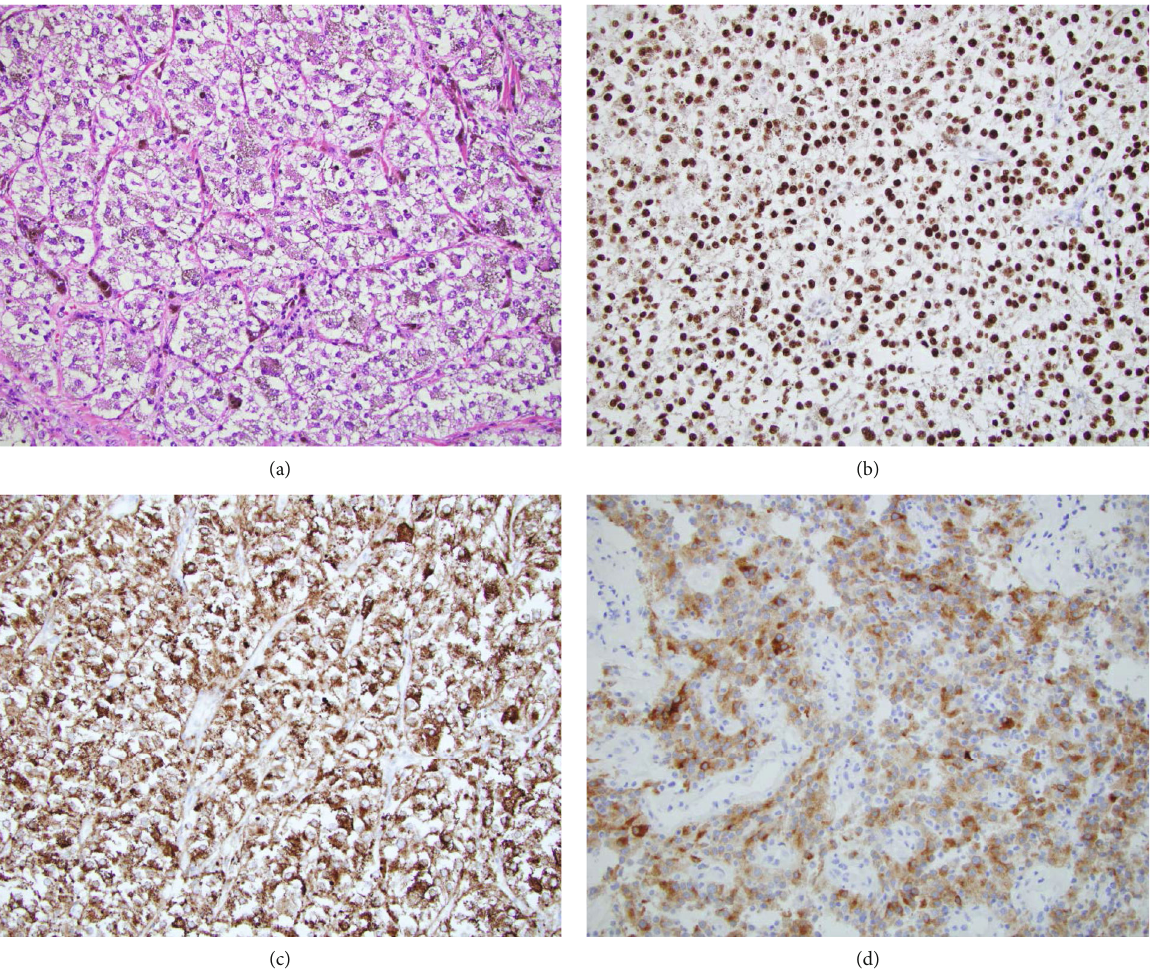
Figure 2: (a) The histologic features of the tumor which were composed of nests and sheets of epithelioid cells with frequent melanin pigmentation separated by thin-walled capillary vessels (predominant alveolar architecture) (hematoxylin and eosin (H&E) staining, magni fi cation × 200). Tumor cells demonstrate immunohistochemical reactivity for (b) TFE3, (c) HMB45, and (d) Melan A (b – d, magni fi cation ×